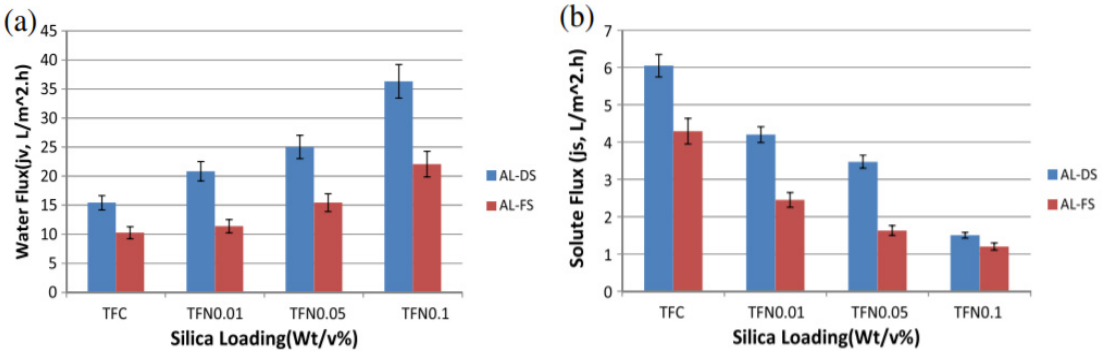
Figure 5. FO water flux and solute flux of synthesized FO membranes. ( a ) FO water flux and ( b ) solute flux (reprinted with permission from [50], Copyright 2014, Elsevier).